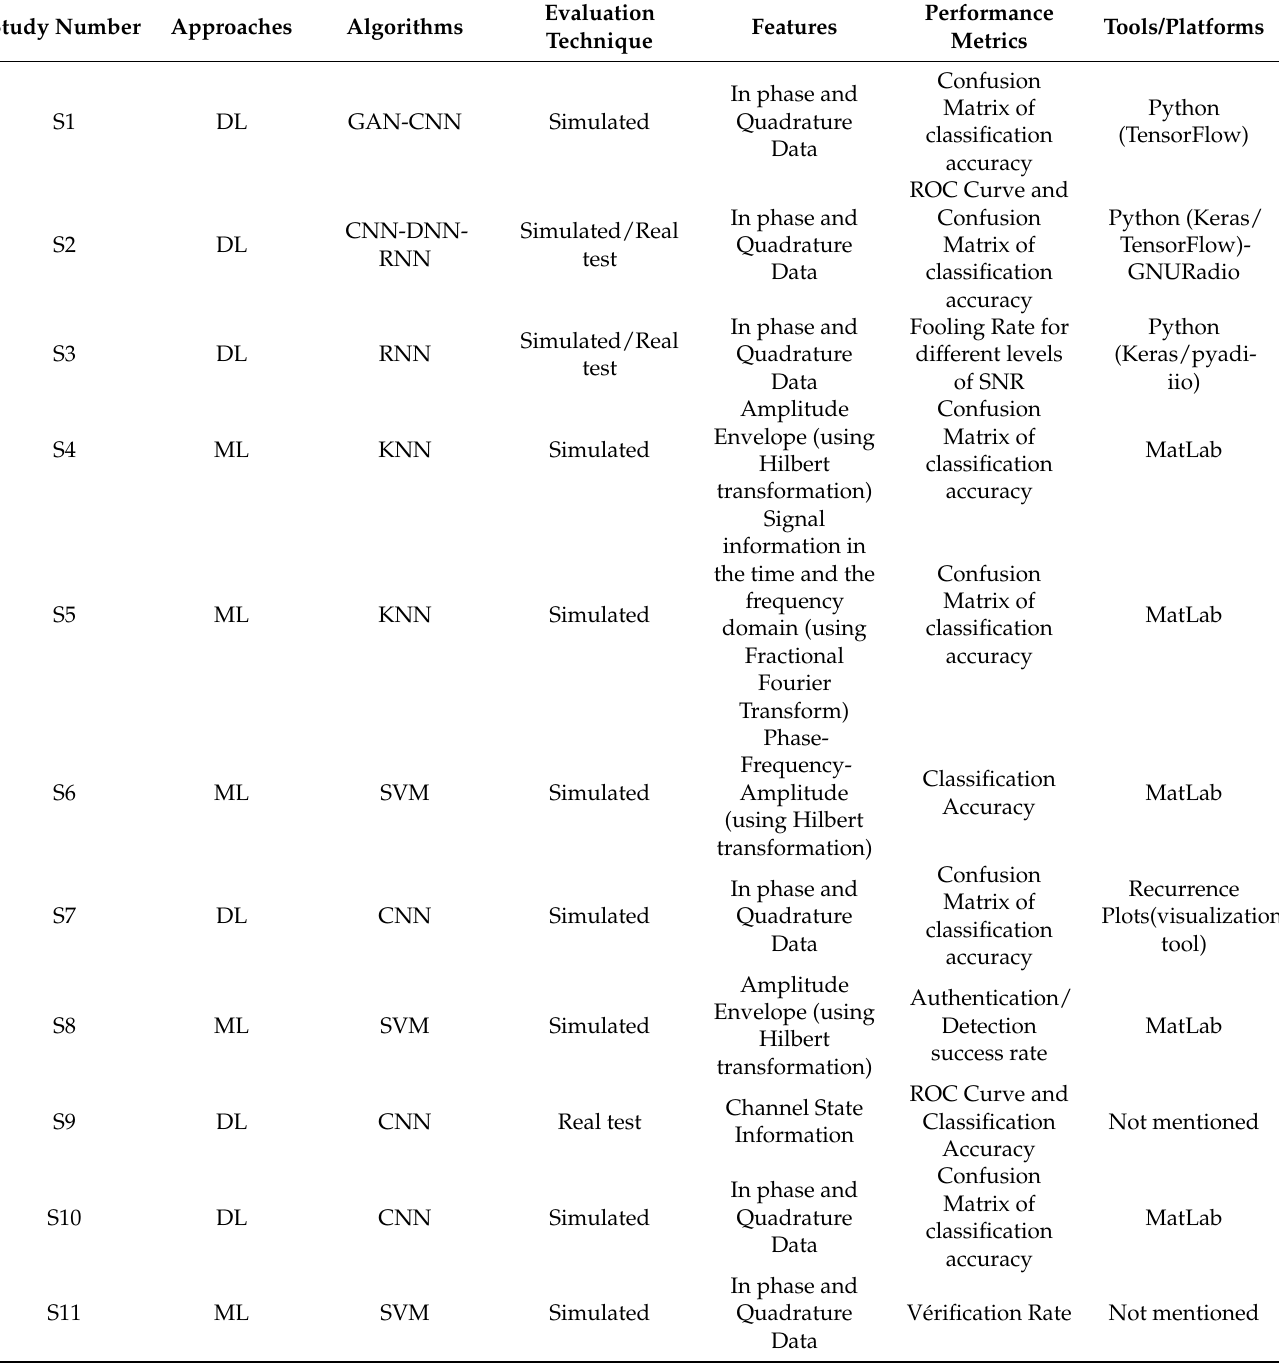
Table 6. Information of the reviewed PLA based machine learning